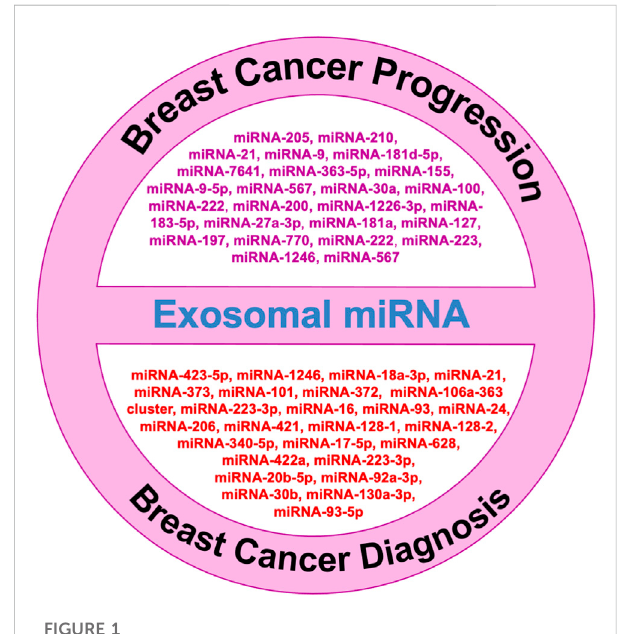
FIGURE 1 Role of exosomal microRNAs in breast cancer diagnosis and